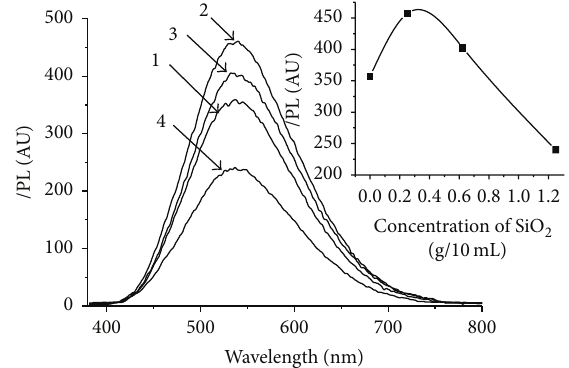
Figure 4: The luminescence spectra of the colloidal solutions of ZnO nanoparticles without SiO 2 (1) and in the presence of 0.25 g (2), 0.625g (3), and 1.25g of silica (4) in 10mL of zinc oxide solution. = 340 nm. The inset shows the [ZnO] = 2 × 10 −2 mol/L, 𝜆 exc . dependency of luminescence intensity of ZnO nanoparticles on the = 540 nm. amount of SiO 2 introduced into the solution. 𝜆 emission